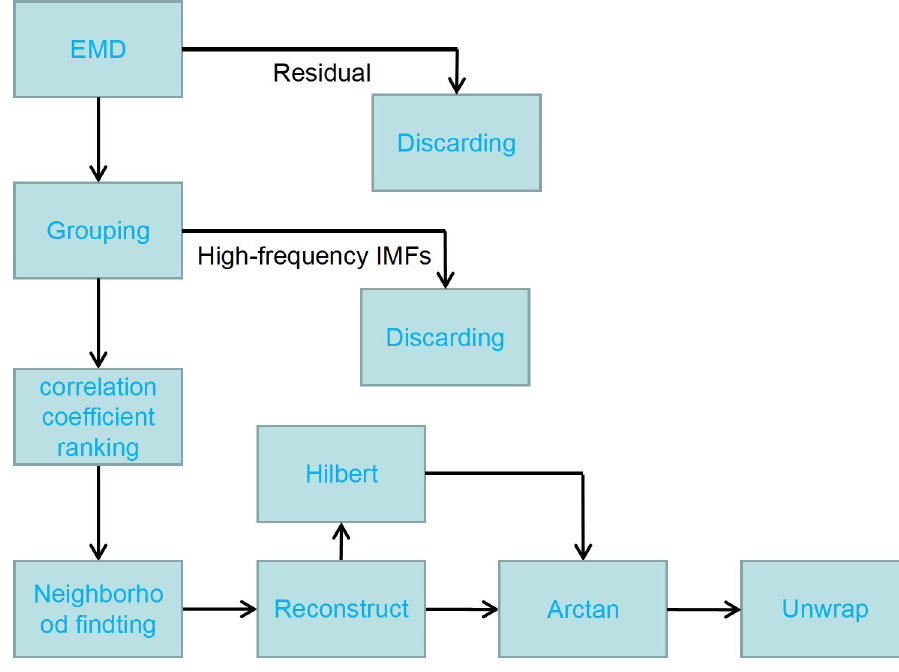
Fig 1. Flowchart of local capping REMD filter.